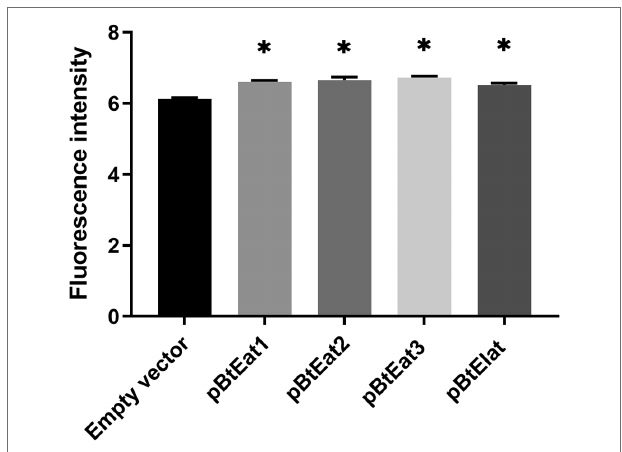
FIGURE 6 | The expression level of EGFP gene in E. coli . Data are presented as mean ± SE ( n = 3). The asterisk represents a significant difference (* p <